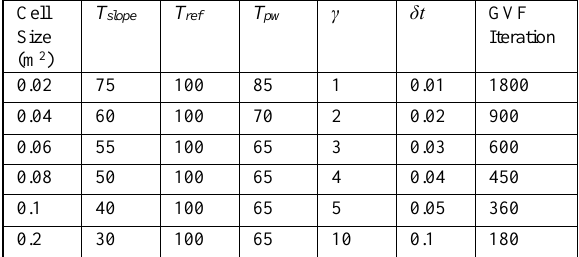
Table 2: Different parameters used in the six test cases of raster cell dimension analysis.